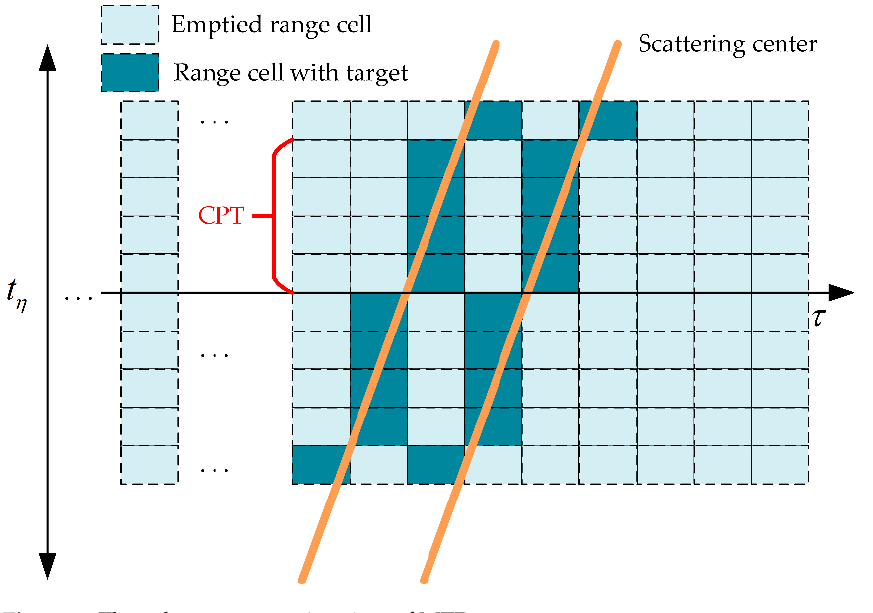
Figure 8. The coherent processing time of MTD.